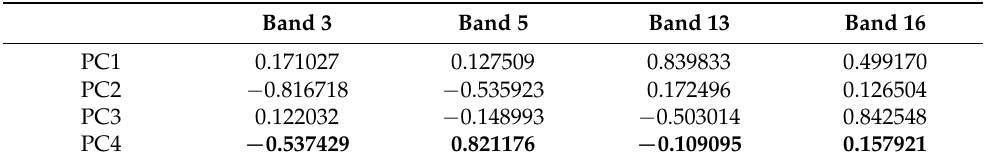
Table 4. Eigenvector matrix of the chlorite by PCA method.